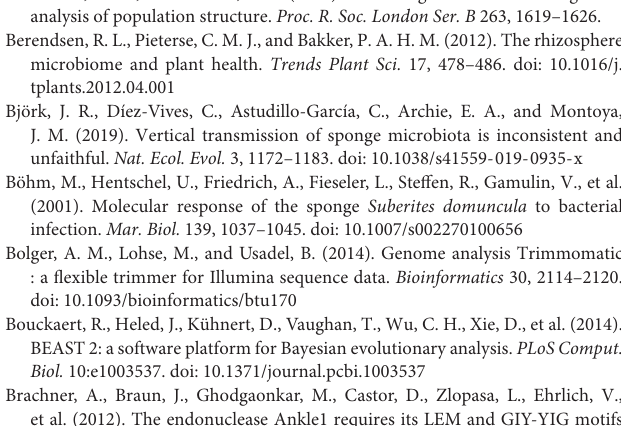
Supplementary Figure 1 | Shannon ( H ) and inverse Simpson ( 1/D ) diversity indices of Ircinia microbiomes and seawater microbial communities, visualized on the SNAPP species tree. Reported values are means with standard error of the mean. Supplementary Figure 2 | PCoAs inferred from the total sponge dataset with specimens and SEAs highlighted by geography emphasize divergence of microbiome compositions among host species within a site. Supplementary Figure 3 | Estimation of delta K using Structure Harvester. K = 4 ancestral populations of Ircinia received highest support via the Evanno method, followed by K =